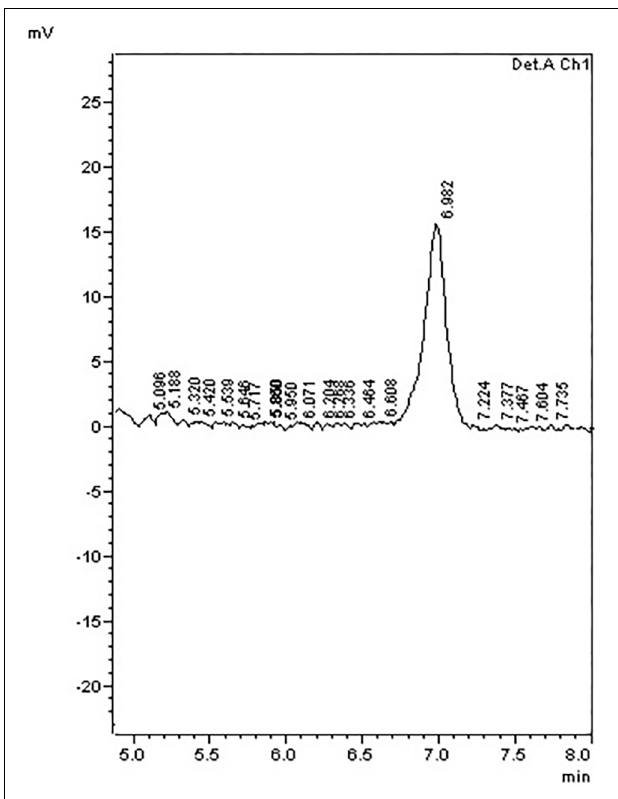
FIGURE 6 | HPLC phytic acid peaks of non-transgenic control seed extracts. germination tests on the lpa seeds collected from our transgenic lines. The CGT test so conducted confirmed that 98% of the test established their high vigor (Supplementary Figure S5A).